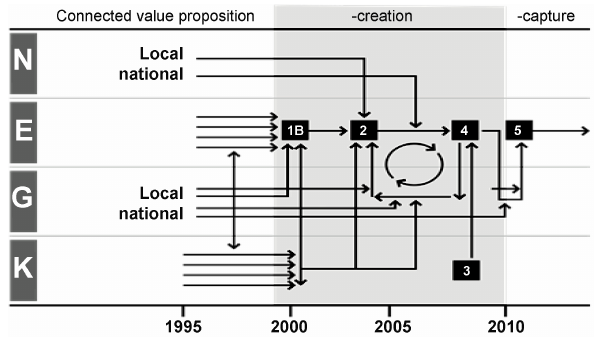
Figure 2. Schematic diagram showing complicated and long- duration interaction patterns between different partners in a trans- disciplinary study, developing a sustainable dairy system in the Netherlands. N: NGOs; E: entrepreneurs; G: government; K: the knowledge arena. In this study (Bouma et al., 2011), the policy cy- cle was simplified here by describing signaling as connected value proposition and design as - creation , which includes decision mak- ing, while implementation corresponds to - capture